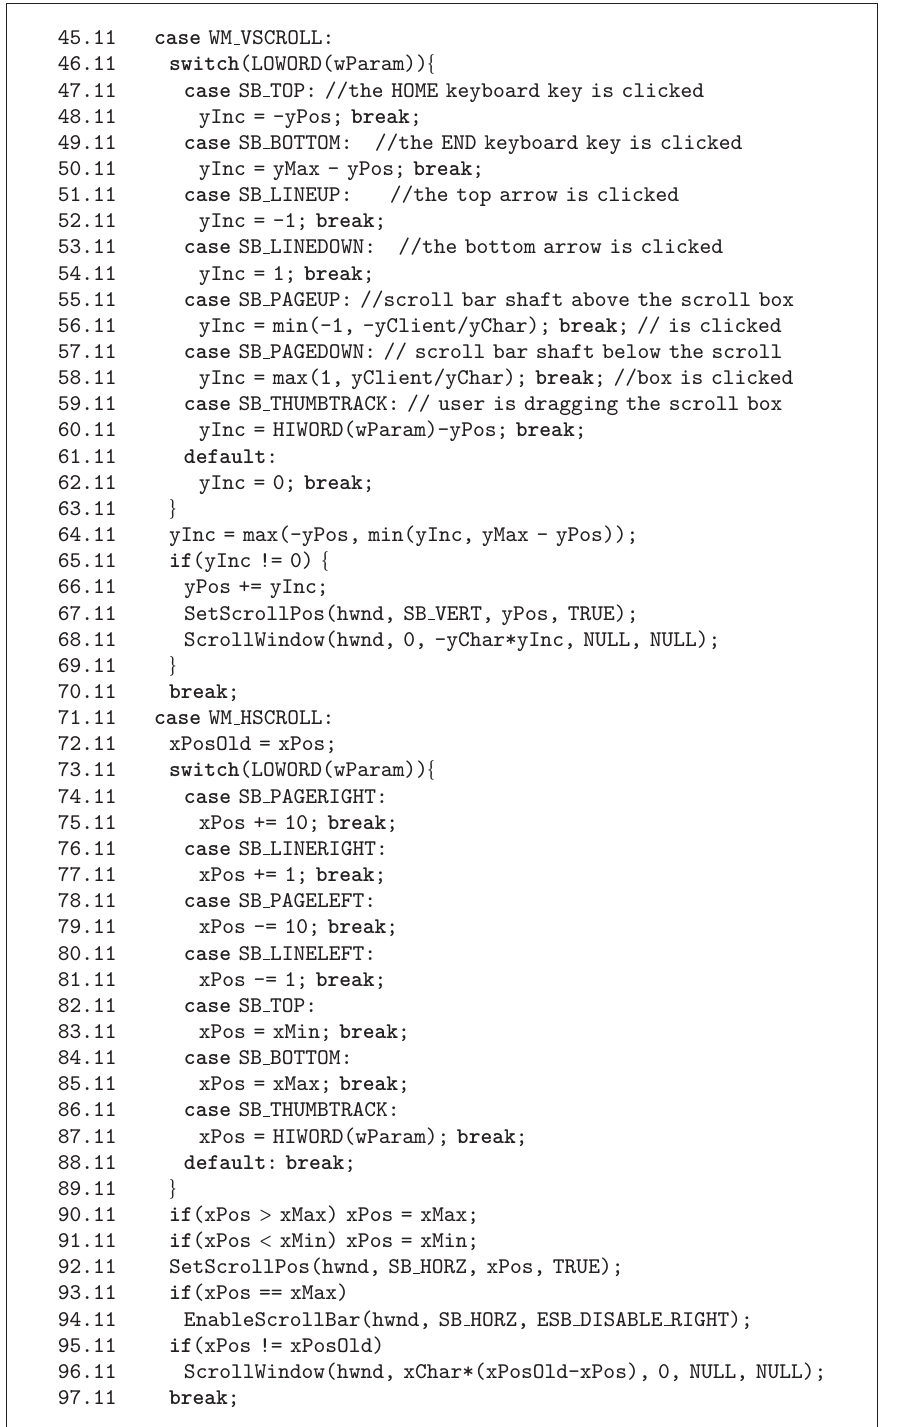
Algorithm 11: Modeless dialog box: function ModelessDialogProc (part